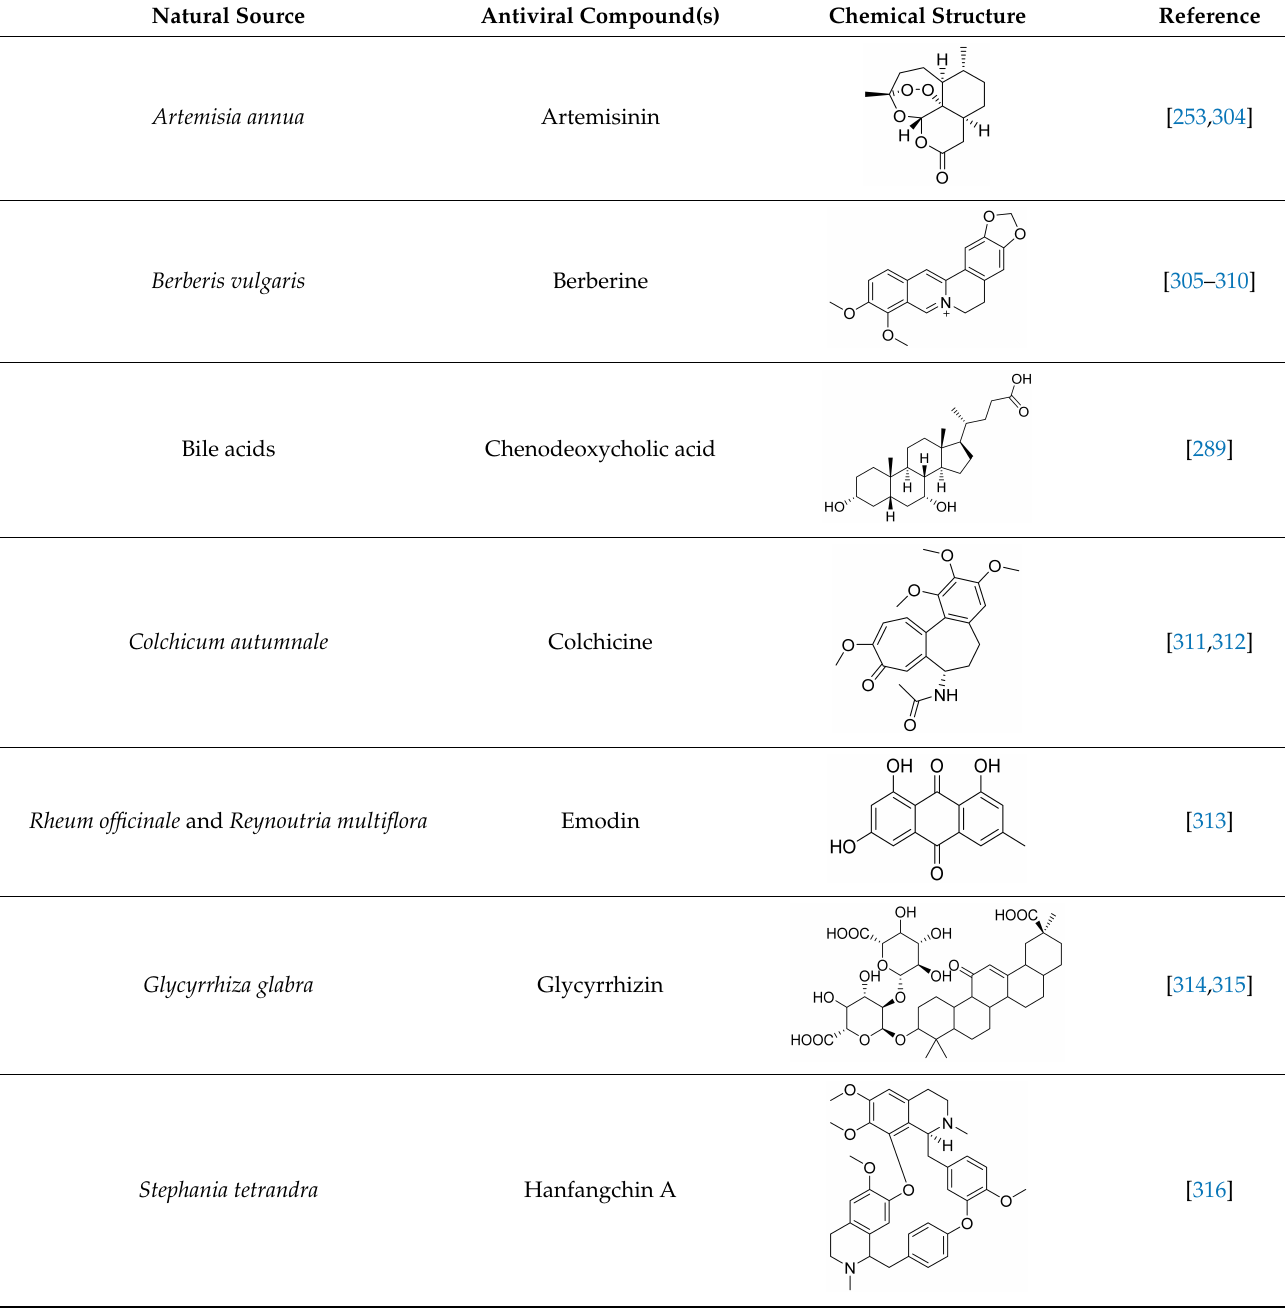
Table 8. Natural compounds under clinical investigations against